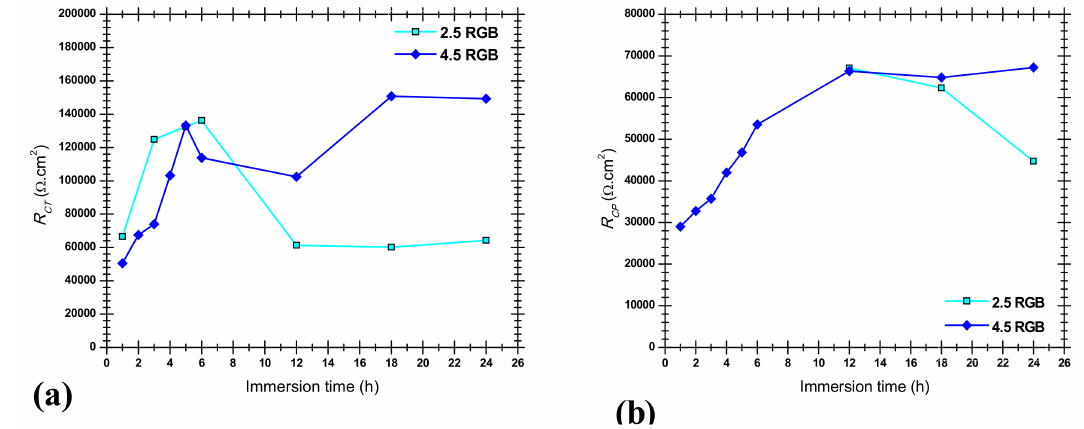
Figure 18. Fitted EIS parameters of ground thick plate (bulk) samples: ( a ) R CT and ( b ) R CP . Values of R CT of thin wall samples in as-cast condition (Figure 16a) decrease with the immersion time for all the samples, which indicates an increase of the activity and a higher corrosion rate in